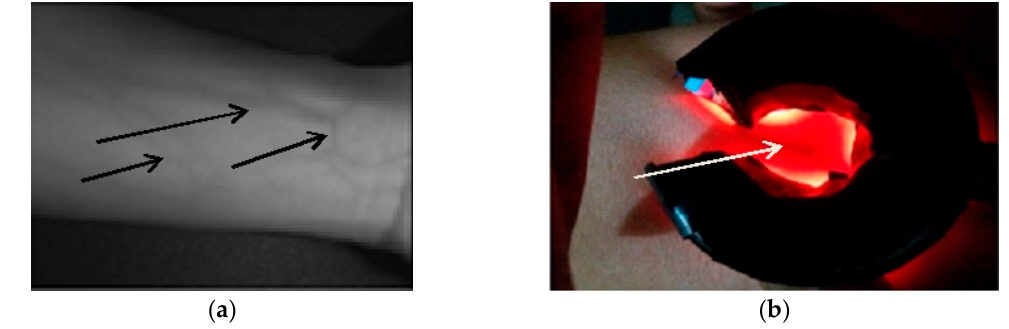
Figure 4. Sample veins image from different wavelengths: ( a ) 850 nm [50] and ( b ) 696 nm